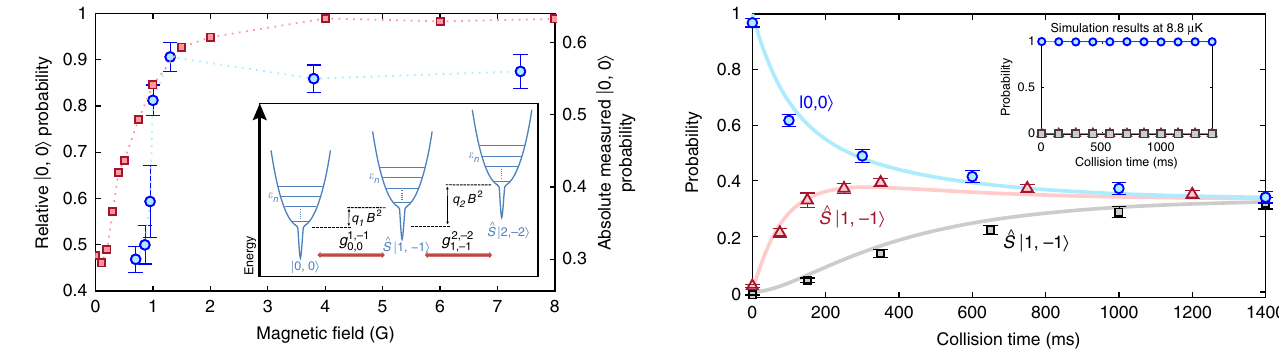
Fig. 4 Spin population dynamics at high bias fi eld. The populations of the two-atom states are plotted as a function of collision time with error bars denoting the standard error of the mean. The solid curves are a fi t of the measured data with spin-changing rate equations, while the ratio of the rates between 0 ; 0 j i " ^ S 1 ; (cid:2) 1 j from the theoretically predicted spin-dependent interaction strengths. The bias fi eld was 8.5 Gauss for all collision times. The inset illustrates that the simpli fi ed theoretical model used for our simulations fails to capture the long-time relaxation dynamics in the high magnetic fi eld regime. Source data are provided as a Source Data fi Þ þ (cid:2) h ω ð n þ 1 Þ þ (cid:2) h ω ð n þ 1 Þ , y y z z 2 2 2 ′ ; m ′ . See Methods for further 1 2 m 1 ; m 2 P ^ r 2 μω 2 1 with j j j 2